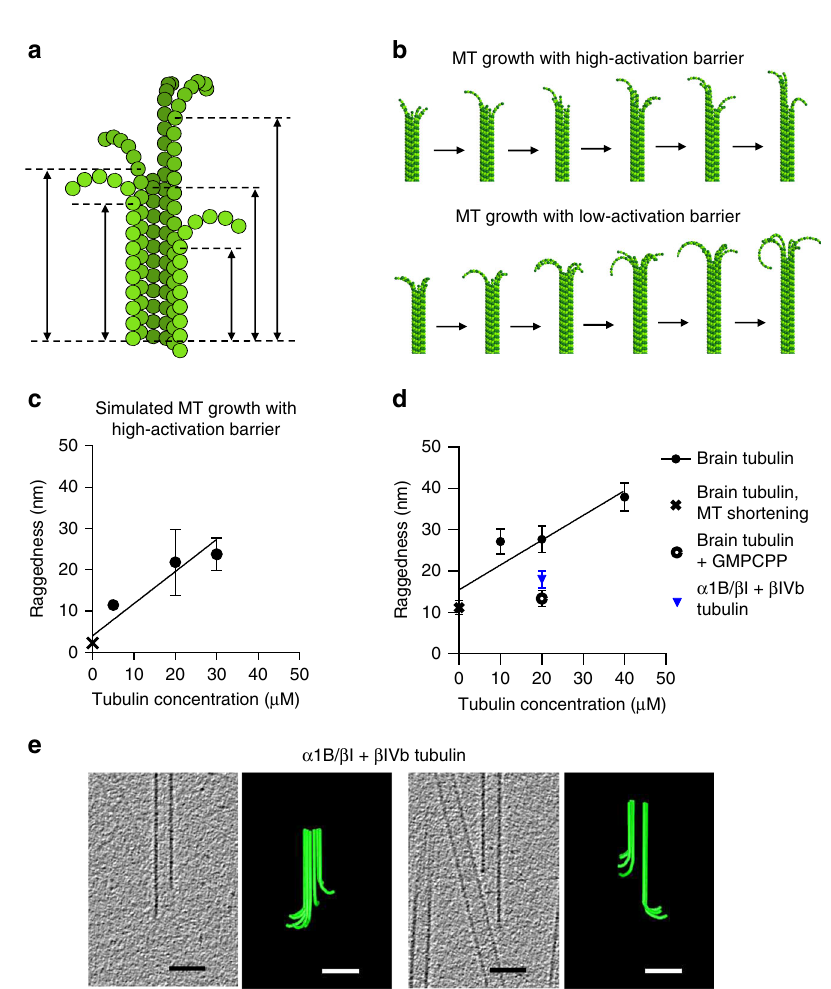
Fig. 7 Raggedness of MT tips grown in different conditions. a Schematic explaining the MT end raggedness parameter. Dashed lines mark the origins of PF curls. Double-ended arrows show distance from a fi xed arbitrary point to the start of each PF curl. Raggedness is de fi ned as the standard deviation of positions of PF curve starts. b Series of snapshots, demonstrating growing GTP-MT end shapes in simulations with high and low lateral activation energies for lateral bonding potentials. More ragged ends tend to form when the activation barrier is high. c Dependence of model GTP-MT end raggedness on tubulin concentration. Data points represent mean ± s.d. from thee repeats of each simulation; source data are provided as a Source Data fi le. d Experimental data on MT raggedness under various experimental conditions. Black points show dependence of MT end raggedness on tubulin concentration. Black line is a linear fi t to these data. Zero tubulin concentration (cross) corresponds to isothermal dilution experiments. Open circle shows data for MT growth in the presence of GMPCPP, blue triangle is growth in α 1B/ β I + β IVb tubulin. All data points show mean ± s.e.m. based on measurements for 15 – 97 MTs; source data are provided as a Source Data fi le. All data points show mean ± s.e.m. e Tomographic slices and models of representative MTs elongating from axonemal doublet MTs in the presence of 20 μ M free α 1B/ β I + β IVb